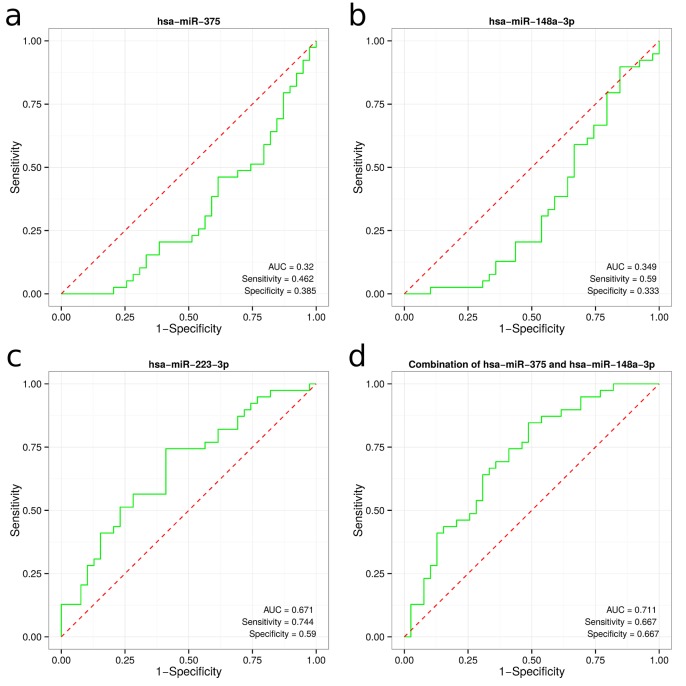
Network of candidate miRNAs and their putative target genes.Network includes the individual miRNAs (red circles) and four types of their predicted mRNA target genes (hexagons), obtained from miRTarBase and miRecords databases. The pink color represents target genes which are regulated by a single miRNA. The orange and green colors indicate target genes regulated simultaneously by two or three distinct miRNAs, respectively. GC-associated target genes retrieved from DisGeNet database are represented by blue hexagons. The databases included in the regulatory interaction networks are identified by the color of the connecting arrows: miRTarBase (blue) and miRecords (red).